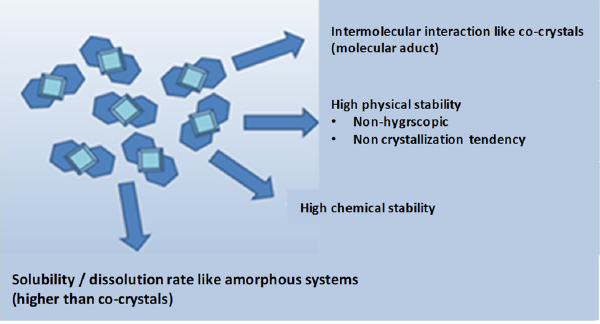
Figure 5. Comparison between co-amorphous and co-crystal solid dispersions.